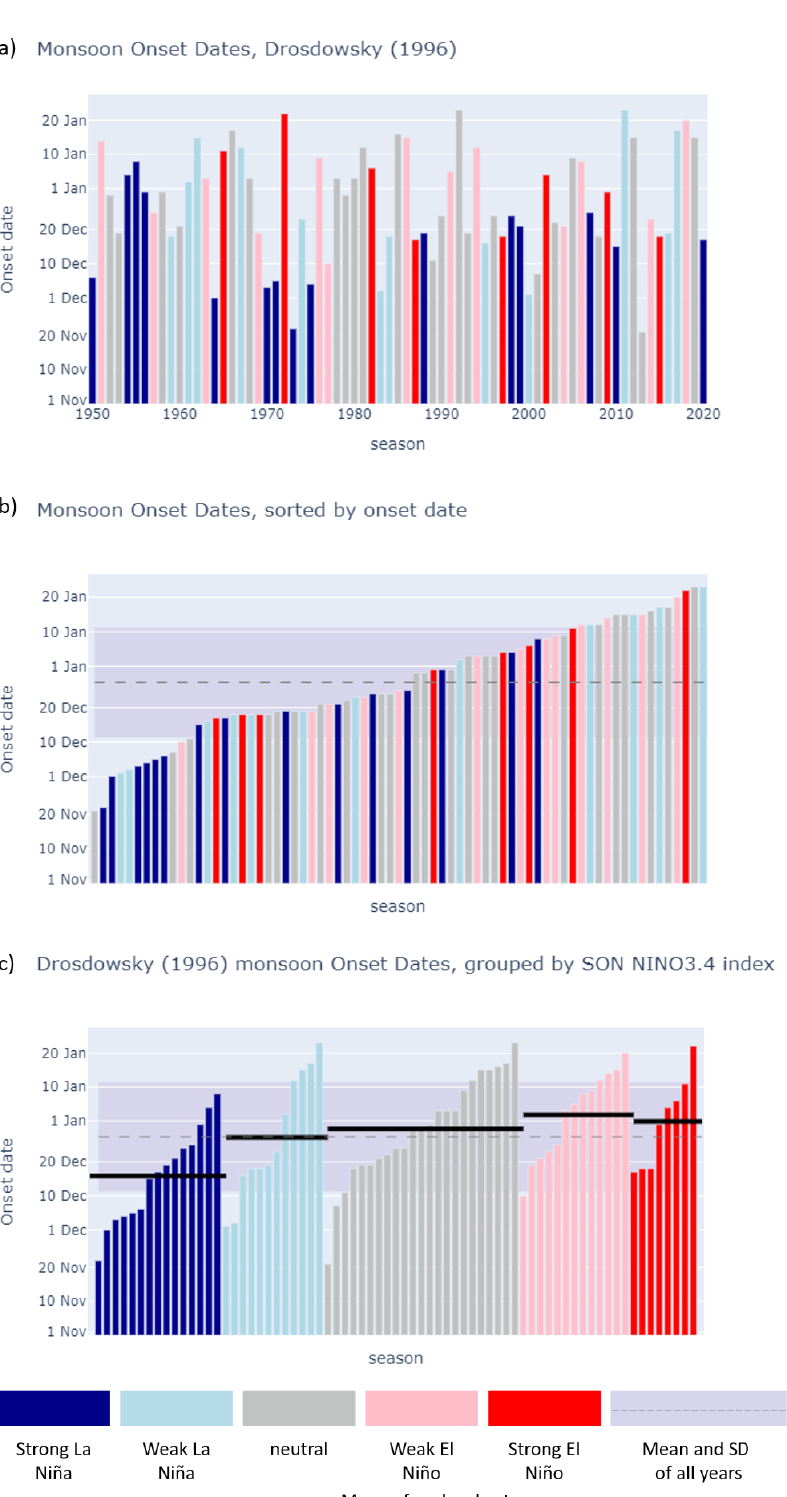
Figure 2. Analysis of Drosdowsky (1996) onset dates with NINO3.4 SST anomalies. Colours are as follows: dark blue = SST < − 0 . 99 ◦ C; light blue =− 0 . 99 ◦ C ≤ SST < − 0 . 5 ◦ C; grey =− 5 ◦ C ≤ SST ≤ + 0 . 5 ◦ C; pink = + 0 . 5 ◦ C < SST ≤ + 0 . 99 ◦ C; and red = SST > + 0 . 99 ◦ C. (a) Monsoon onset dates for each season, coloured by NINO3.4 SST anomalies. (b) Monsoon onset dates sorted by onset date and coloured by NINO3.4 SST anomalies. (c) Monsoon onset dates grouped by ENSO state and coloured by NINO3.4 SST anomalies.